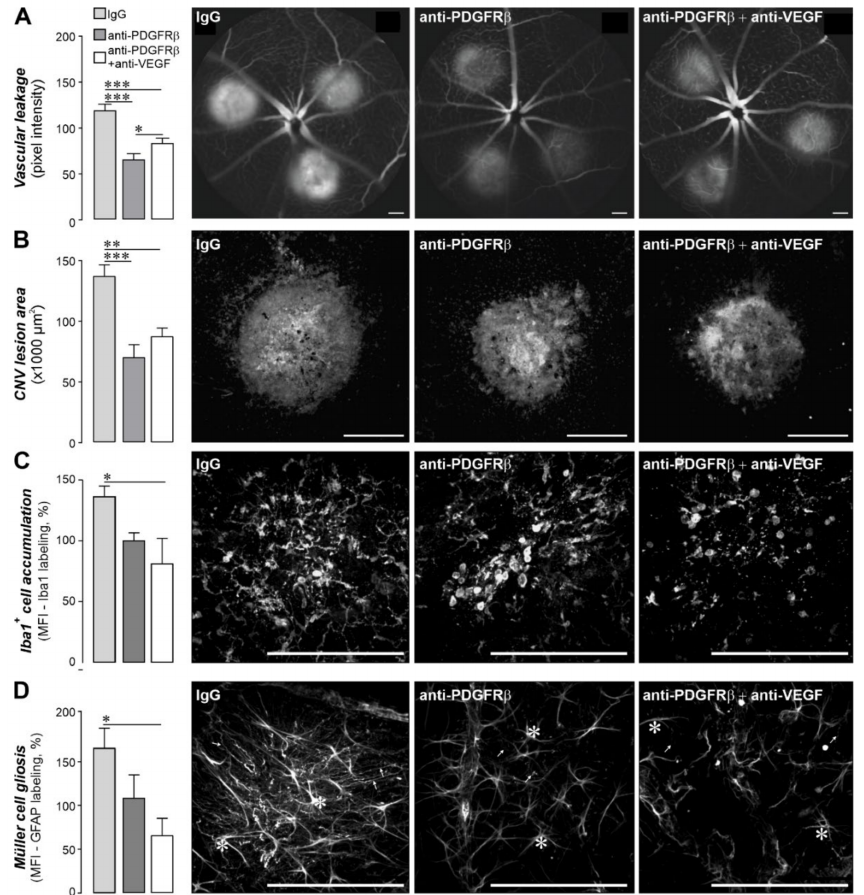
Figure 6. Anti-PDGFR β treatment has similar effects on vascular integrity and the glial response pattern as a combined anti-PDGFR β /anti-VEGF therapy in a murine model of choroidal neovascularization (CNV). ( A ) Left , quantification of vascular leakage by analyzing pixel intensities at 3 days after laser- induced retinal damage. The follow antibody concentrations were used: IgG control (1 µ g), anti-PDGFR β (1 µ g), or anti-PDGFR β + anti-VEGF (each 1 µ g). Data are shown as mean ± SEM (n = 14–20 eyes). Right , fluorescence angiography performed on eyes at 3 days after laser lesion to assess data on the functional integrity of the retinal/choroidal blood vessels with or without treatment with anti-PDGFR